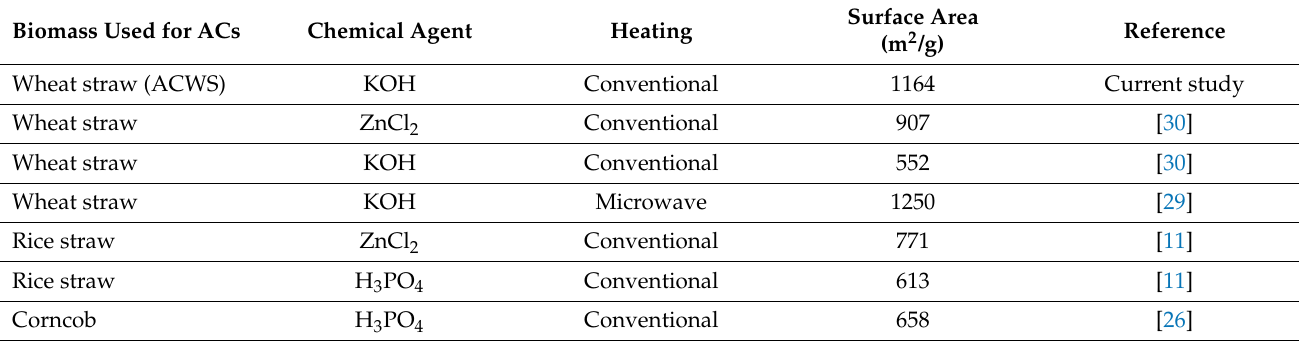
Table 4. Comparative between the fabricated ACWS in the current study and other adsorbents in previous studies.